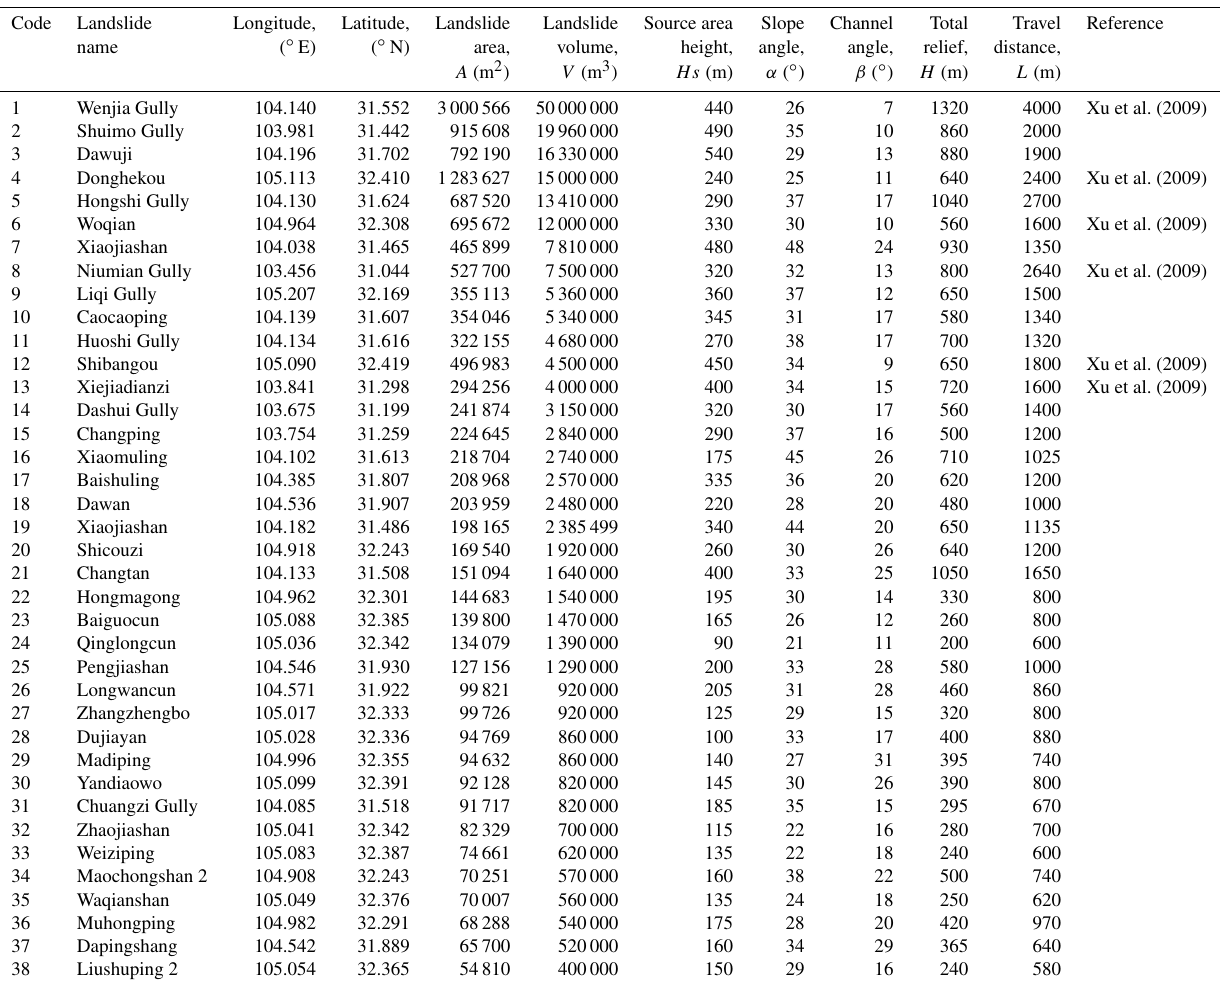
Table 2. Data of various factors for establishment of prediction model of rock avalanche travel distance. Code Landslide Longitude, Latitude, Landslide